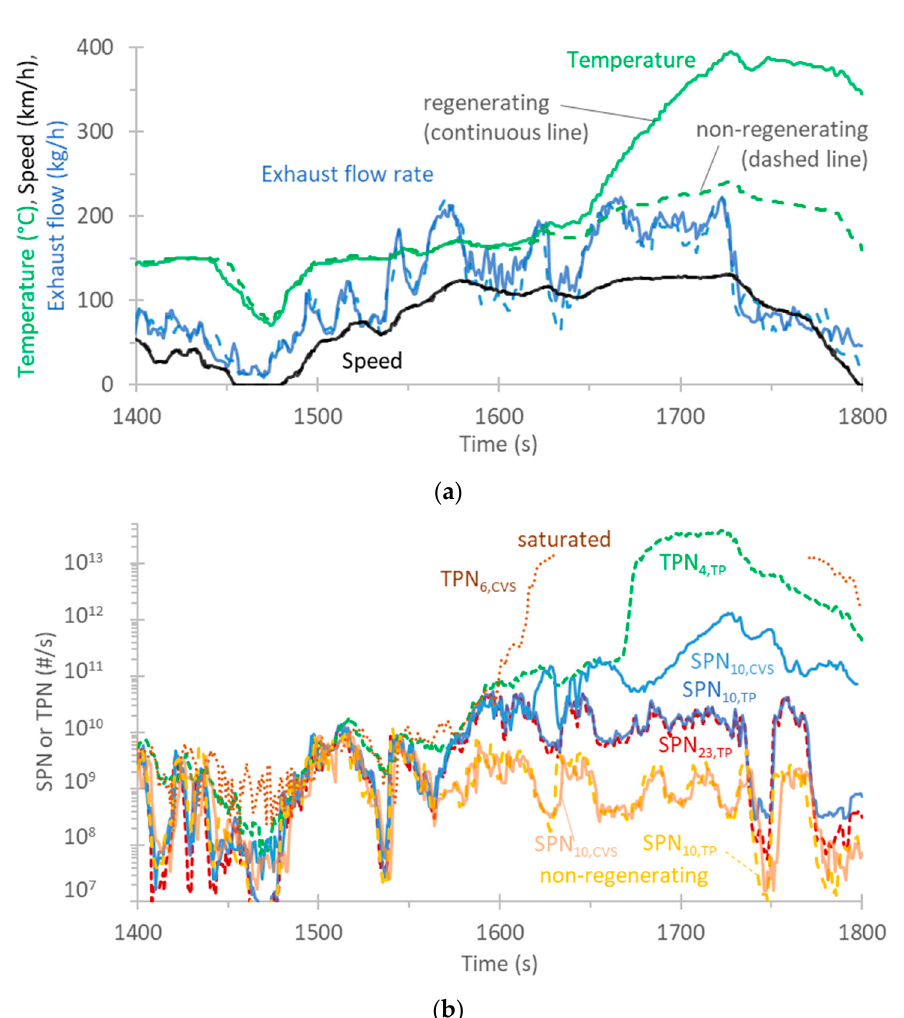
Figure 6. Comparison of regenerating and non-regenerating WLTCs with vehicle #2 (Euro 6b): ( a ) exhaust gas temperature at the tailpipe, speed, and exhaust flow rate. Continuous lines are data from regenerating cycle. Dashed lines from non-regenerating cycle; ( b ) solid particle number (SPN) and total particle number (TPN) emissions of the regenerating cycle. Only the 10 nm SPN at the tailpipe (TP) and dilution tunnel (CVS) is shown for the non-regenerating cycle for better clarity.